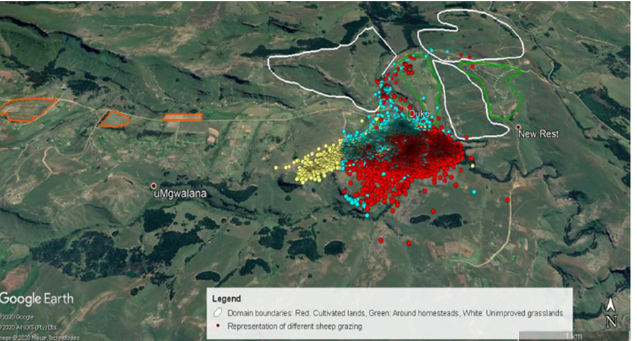
Figure 7. Google Earth plot showing the grazing distribution of three different sheep during the wet season.